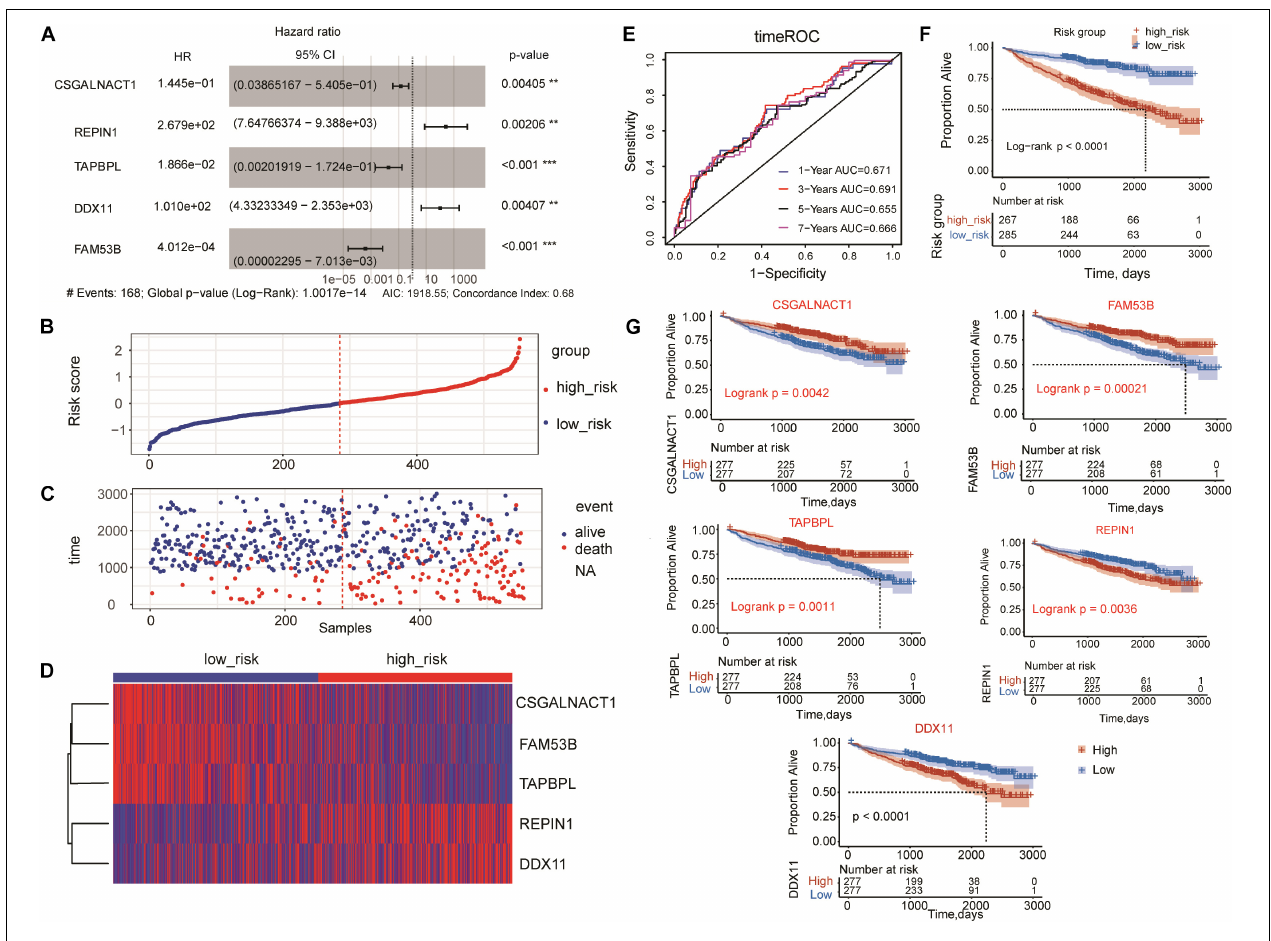
FIGURE 4 | Risk score model based on five-gene signature in MM. (A) Multivariate Cox regression analysis of the five genes (** p < 0.01 and *** p < 0.001). (B) five-gene risk score distribution. Multiple myeloma patients were divided into the high-risk group and low-risk group based on the cut-off value. (C) The survival status and time in high-risk and low-risk groups. (D) The expression profiles of the five genes in high-risk and low-risk groups. (E) Time-dependent ROC curves for the five-gene model to predict patient survival. (F) Kaplan-Meier analysis of the five-gene risk score model to predict patient survival. Upper: Kaplan-Meier curve of the overall survival between the high-risk and low-risk groups. Lower: the number of patients at risk in the high-risk and low-risk groups at different time points. (G) Kaplan-Meier survival plots of the five prognostic genes CSGALNACT1 , REPIN1 , TAPBPL , DDX11, and FAM53B for multiple myeloma